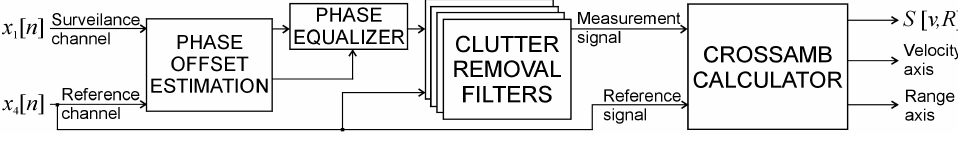
Figure 9. PCL processing algorithm modified for long integration periods.